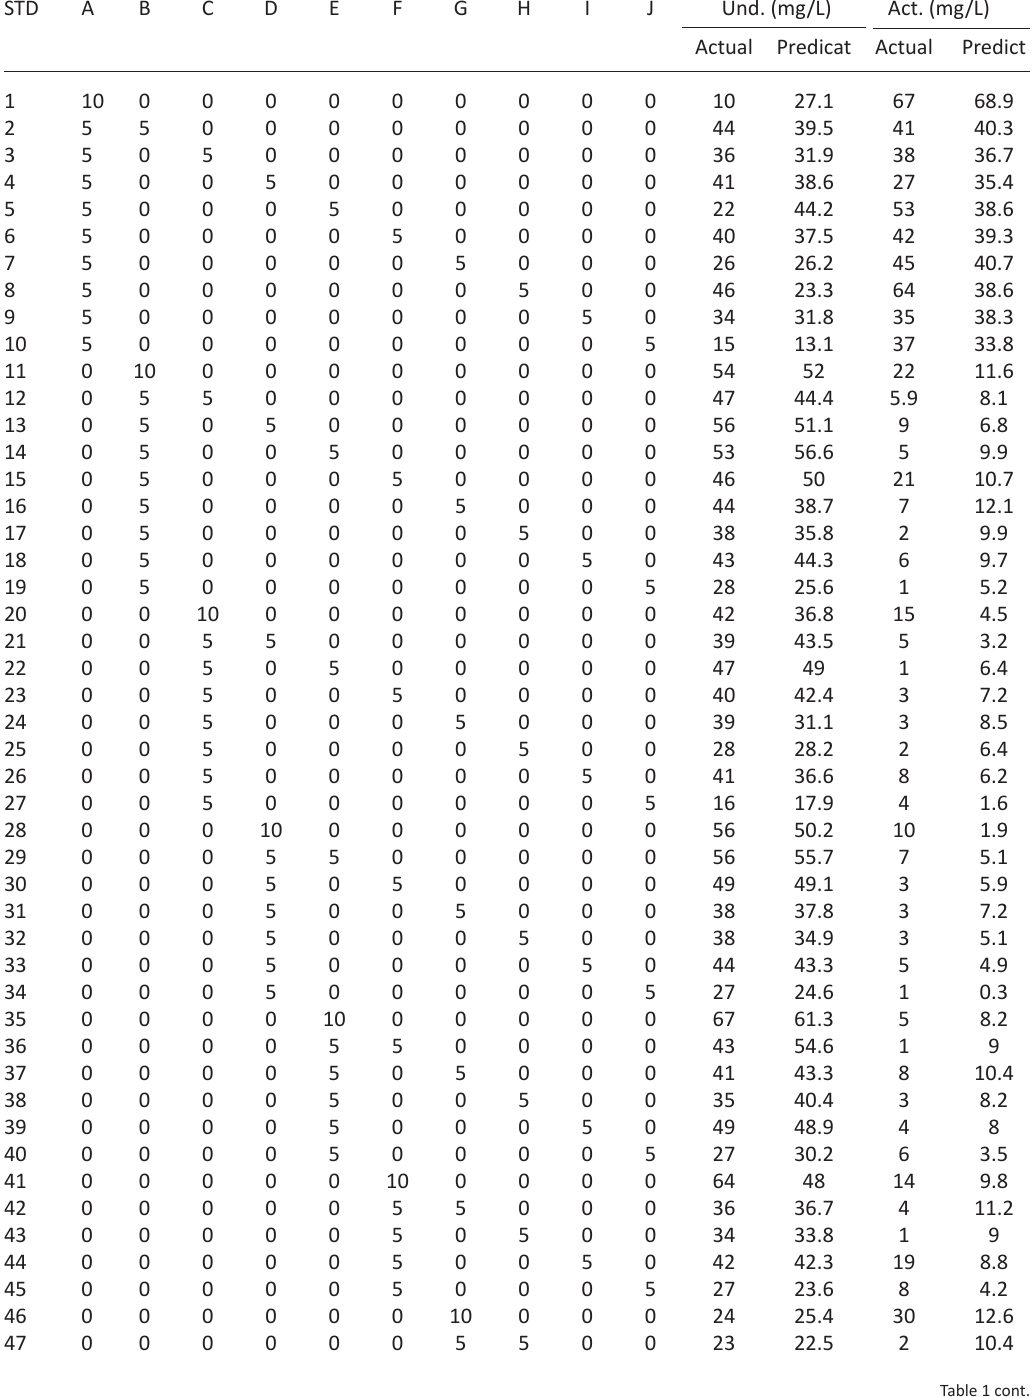
Table 1. Experimental design for actinorhodin and undecylprodigiosin production along with actual and predicted response for ten carbon